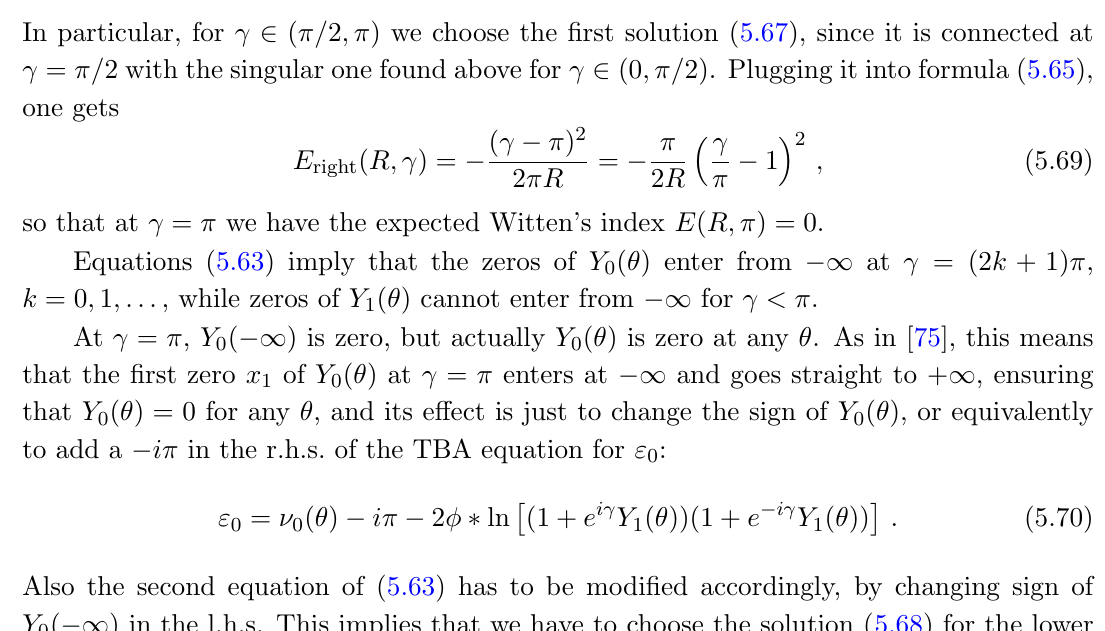
Figure 5 . Comparison of our numerical results with analytic formulas (5.66), (5.69) and (5.76), for R =